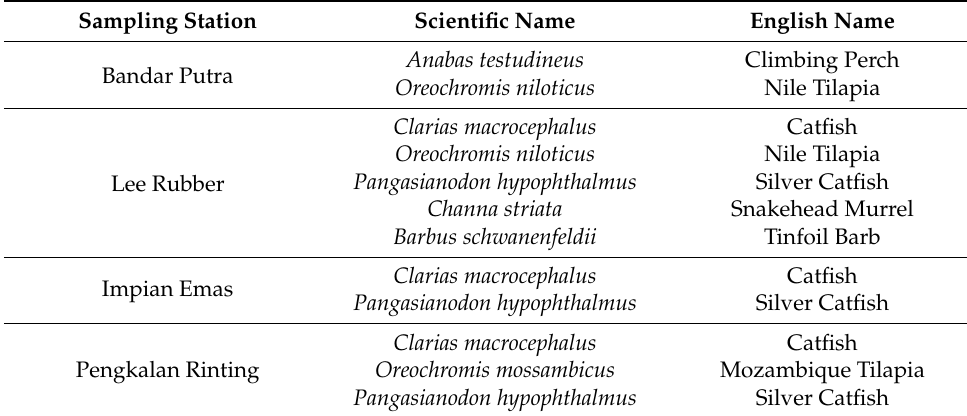
Table 1. The recorded examined fish species.